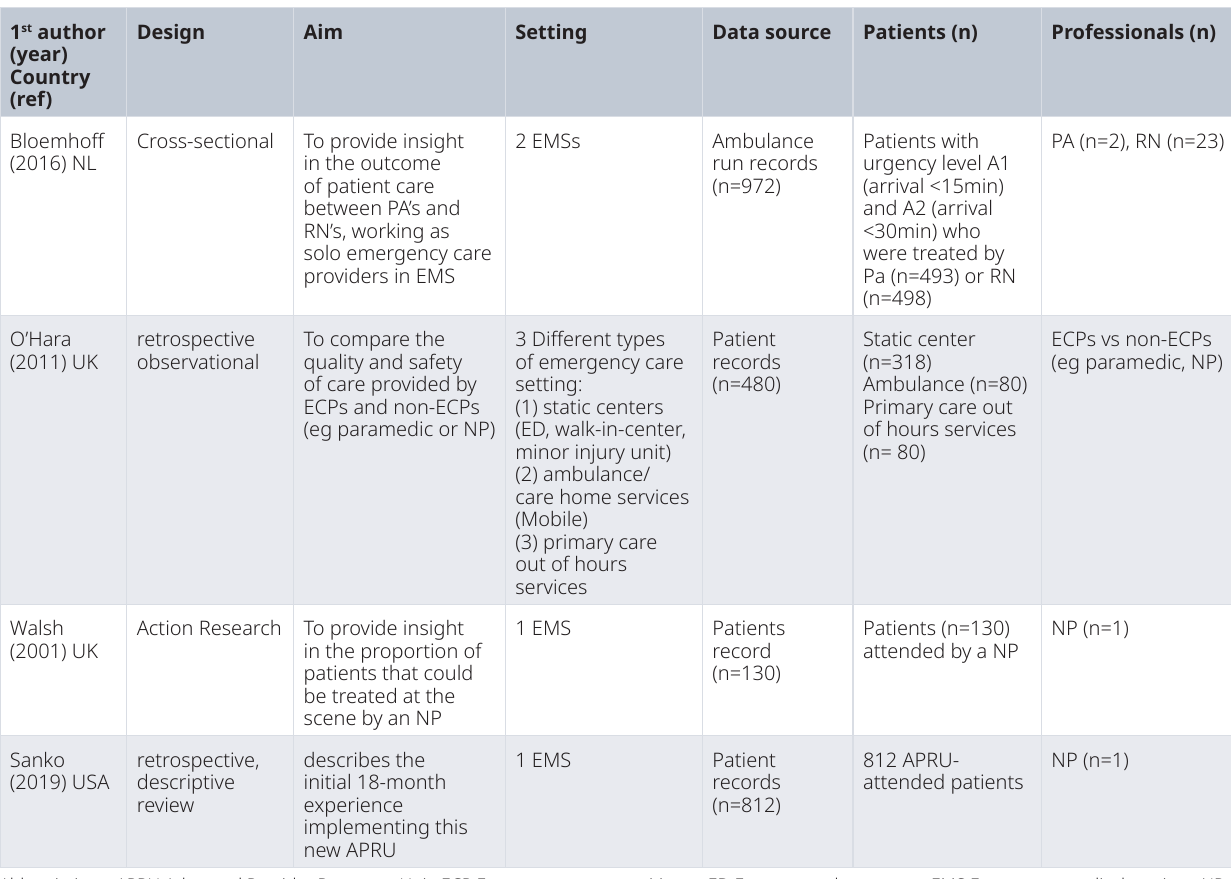
Table 1. Characteristics of quantitative included studies